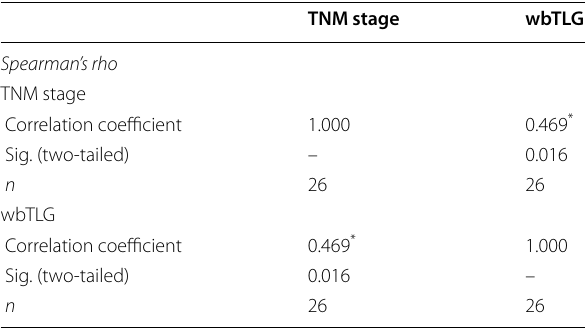
Table.8 Correlation between wbTLG and TNM stage